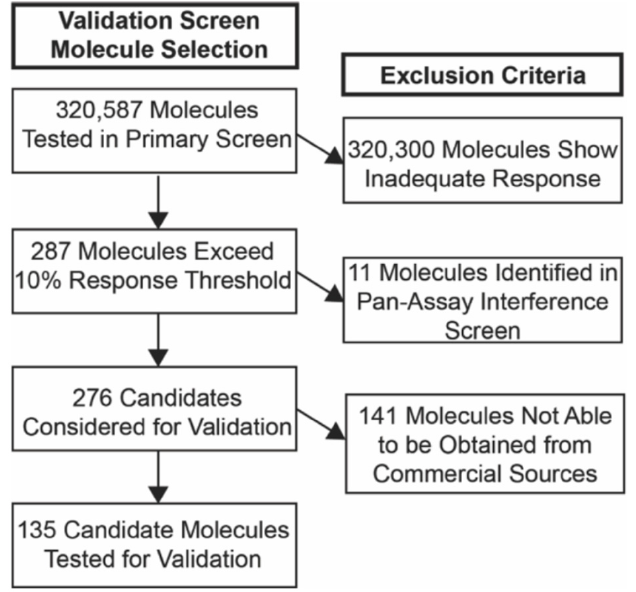
Figure 3. Selection of candidate molecules for secondary screen. Flow diagram shows process for selecting candidates for validation experiments.